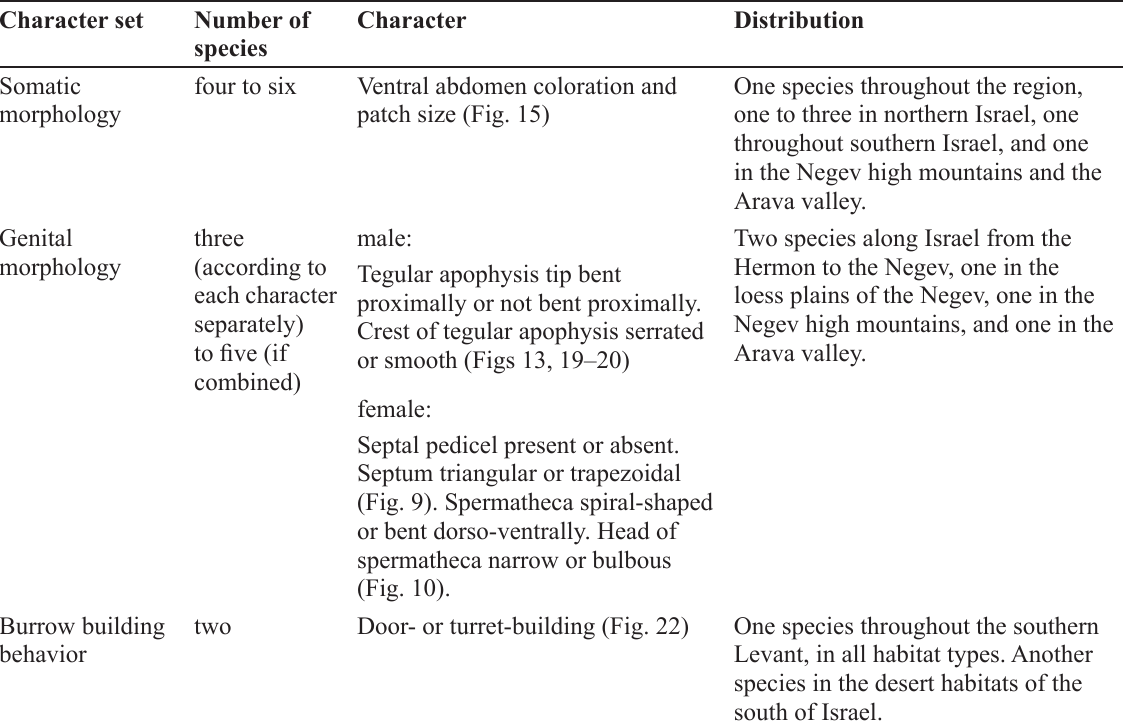
Table 1. Species of Lycosa Latreille, 1804 delimitation